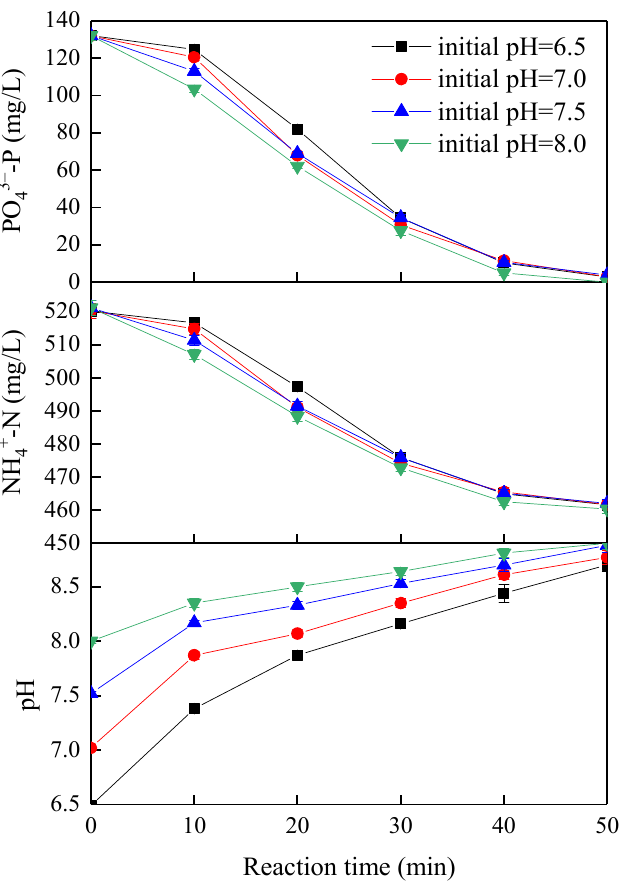
Figure 2. Effect of initial pH on nutrients removal (current density of 4 mA/cm 2 ).